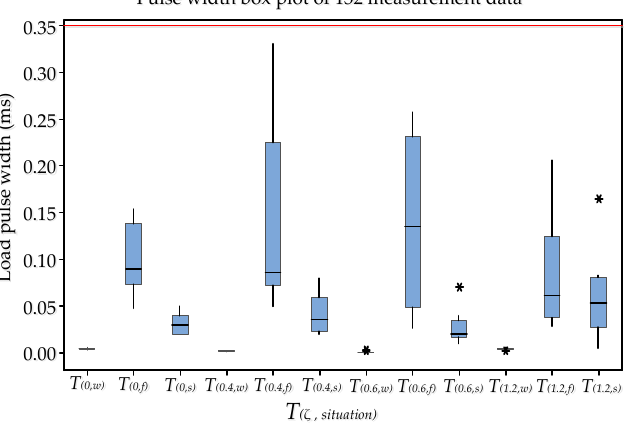
Figure 17. The pulse width box plot of 132 measurement data. The ordinate in this figure represents the load pulse width, with the units in ms. The abscissa in the figure represents T ( ζ , situation ) and ζ represents curvature. “Situation” is represented by “w”, “f”, and “s”, where “w” is the pulse width of the shockwave load, “f” is the pulse width of the first bubble collapse load, and “s” is the pulse width of the second bubble collapse load. “*” represents the outlier in the box.